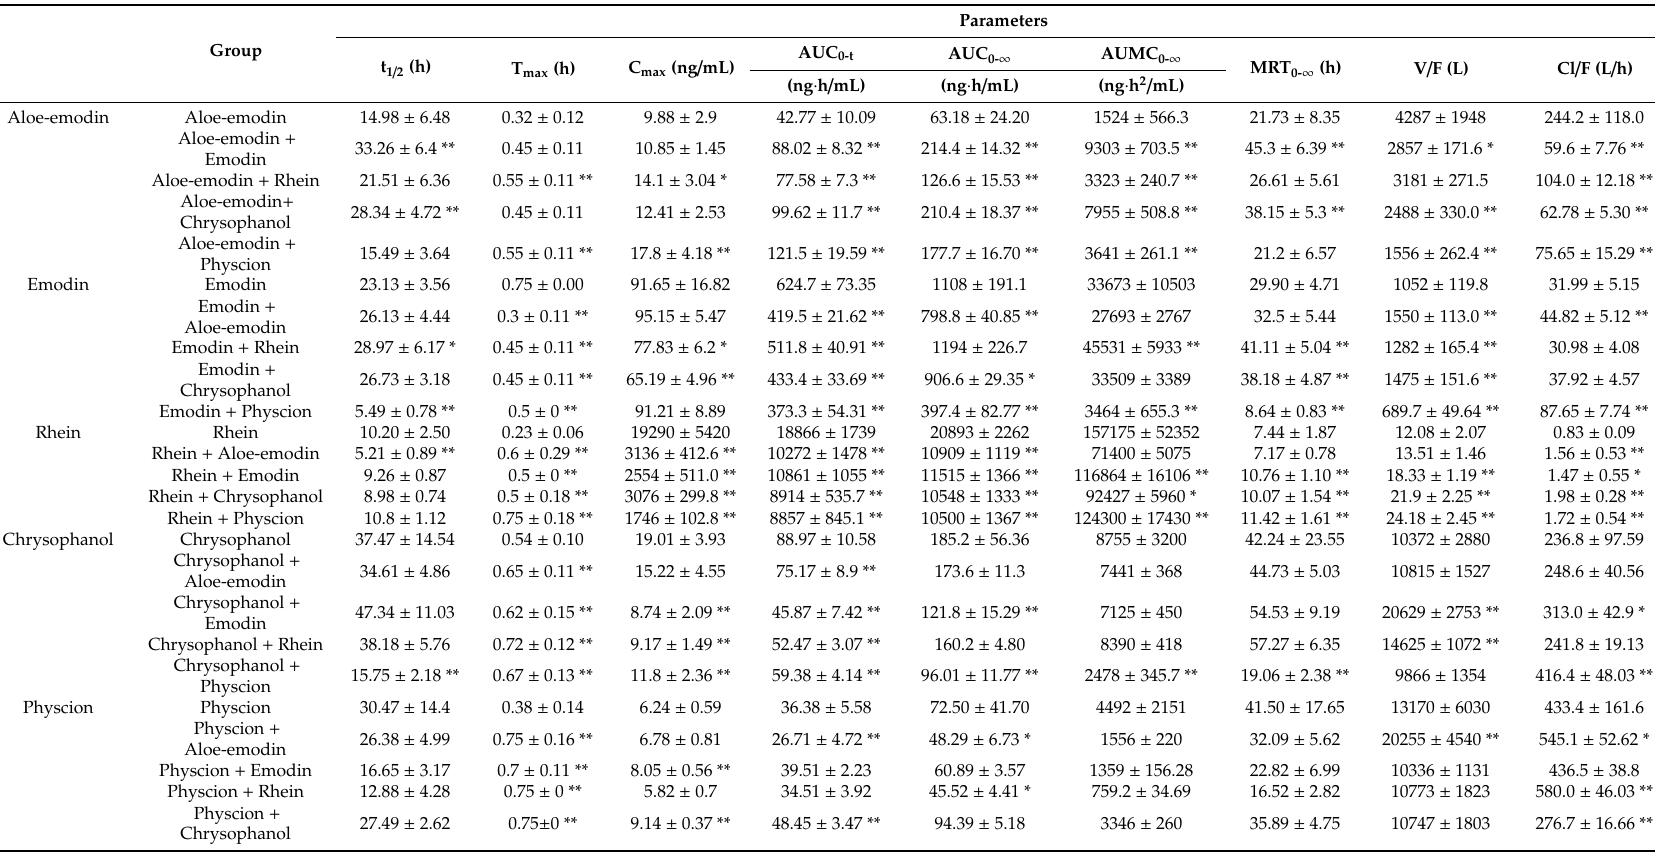
Table 2. Pharmacokinetic parameters of 5 substances in di ff erent groups (mean ± SD; n = 10). The pharmacokinetic parameters were calculated according to the blood concentration time of each subject, and then the mean values and SD values of 10 individual pharmacokinetic parameters in each group were calculated. One-way ANOVA and bilateral test were used to compare the pharmacokinetic di ff erences between the compatibility groups and their corresponding groups which the subjects were administered one of the aglycones (* p < 0.05; ** p <